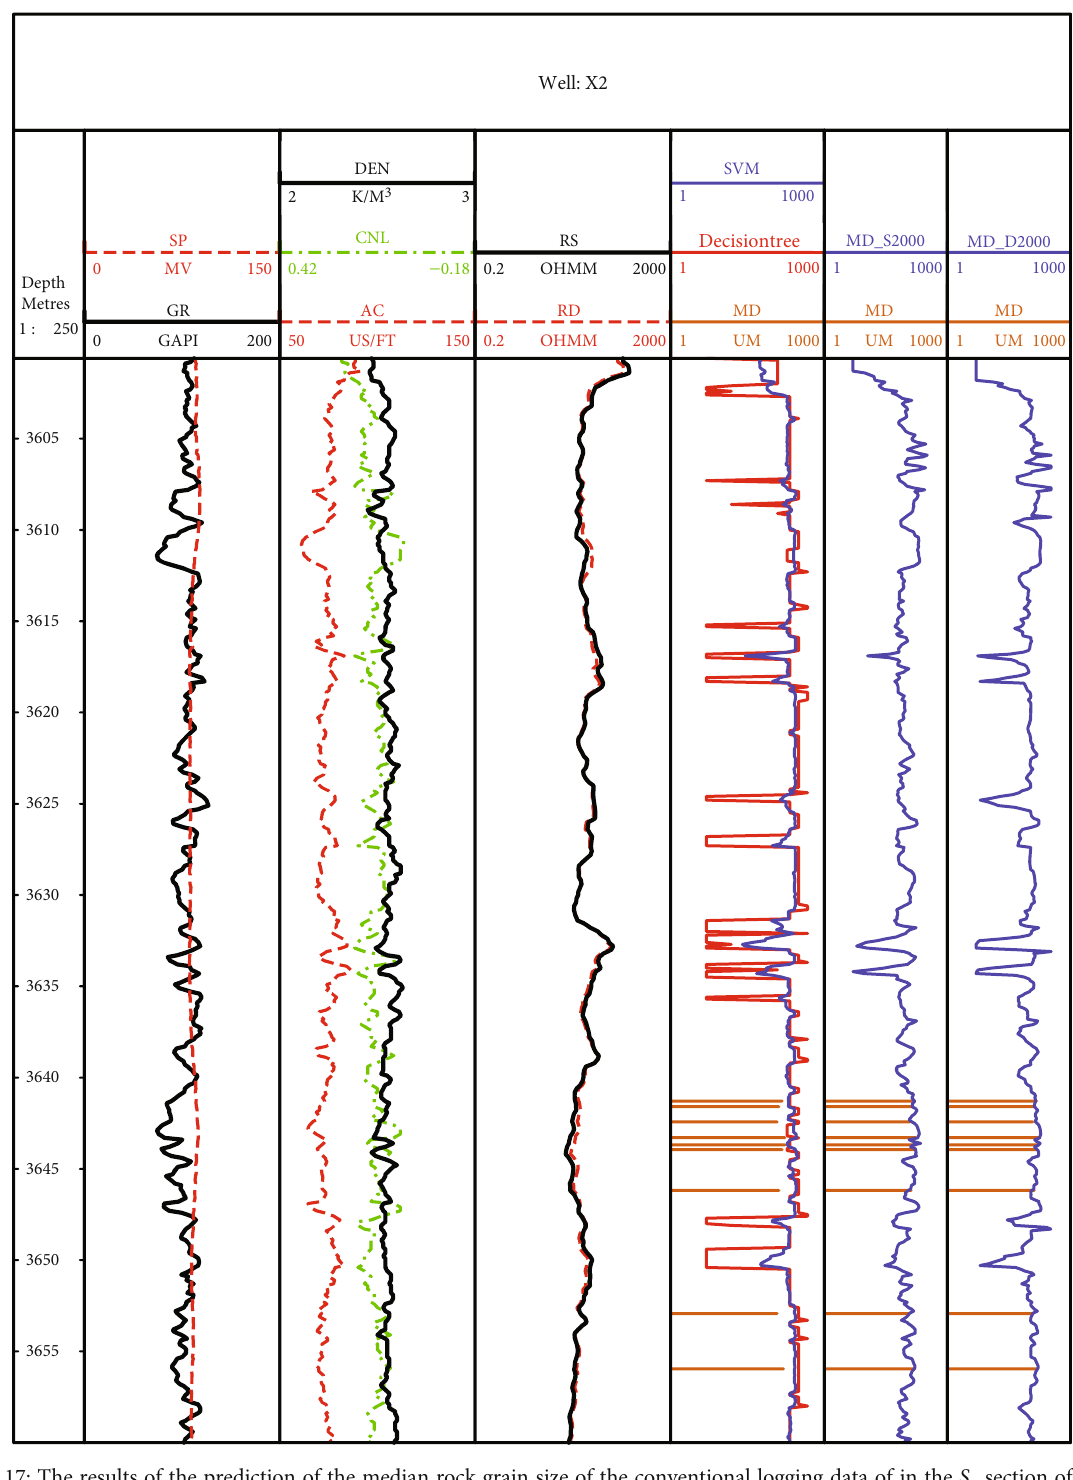
section of well 3